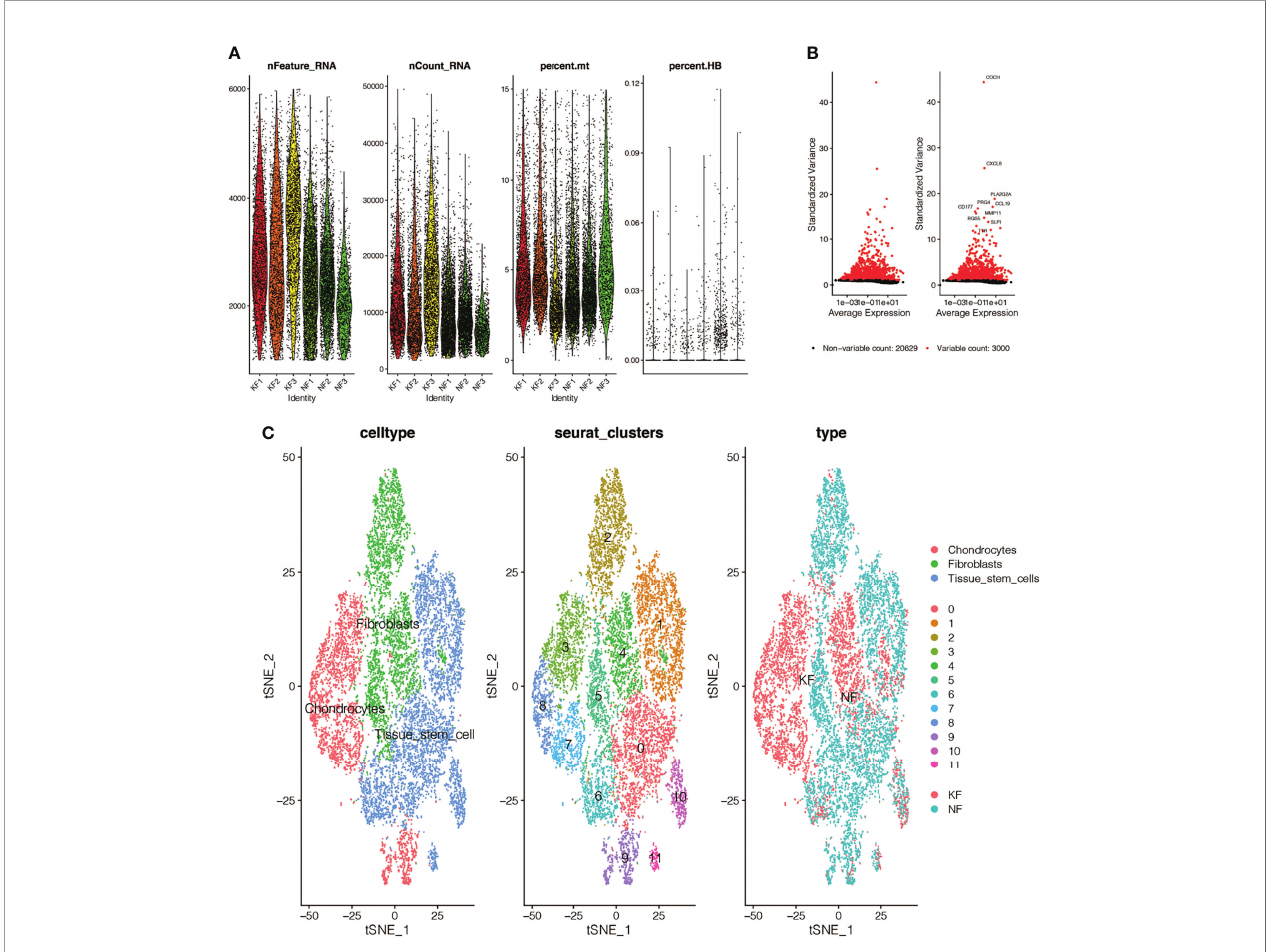
FIGURE 2 | Single-cell quality control and dimension reduction clustering in GSE163973. (A) The percentage of mitochondrial genes and erythrocyte genes is limited to ensure the reliability of cell samples. (B) 3000 highly variable genes are shown in red, with the top 10 highlighted. (C) Dimensionality reduction and cluster analysis. The cells in the keloid dataset can be divided into 12 clusters, which can be roughly summarized as chondrocytes, fi broblasts and tissue stem